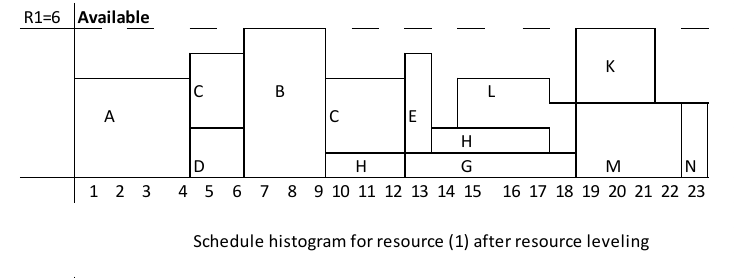
The value of the objective function Resource type Maximum Resource